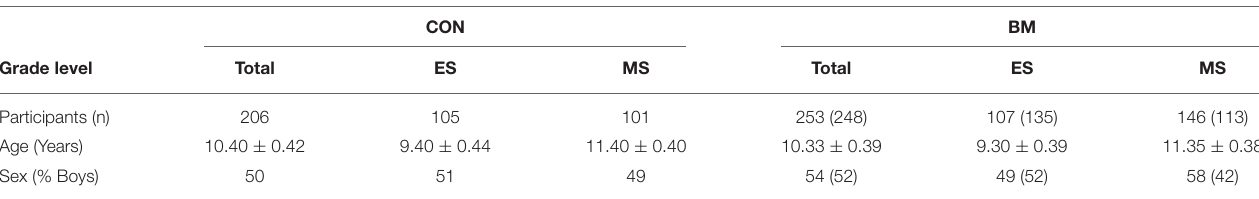
TABLE 1 | Demographics for the two intervention groups (CON, BM).